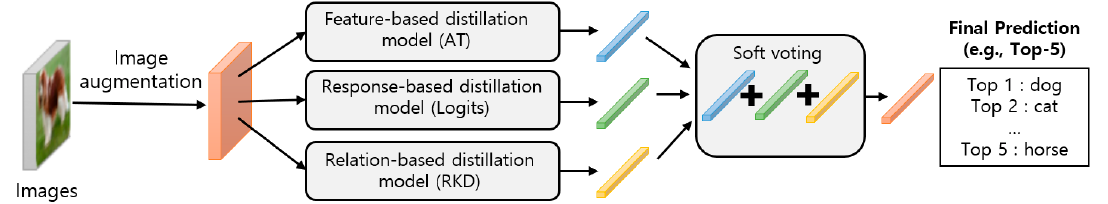
Figure 5. Overall architecture of our proposed ensemble model.